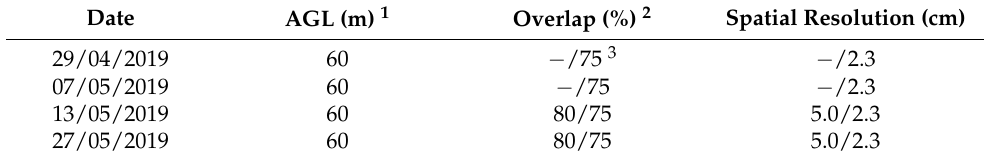
Table 2. Unmanned Aerial Vehicles (UAV) data collection timeline and flight specifications.